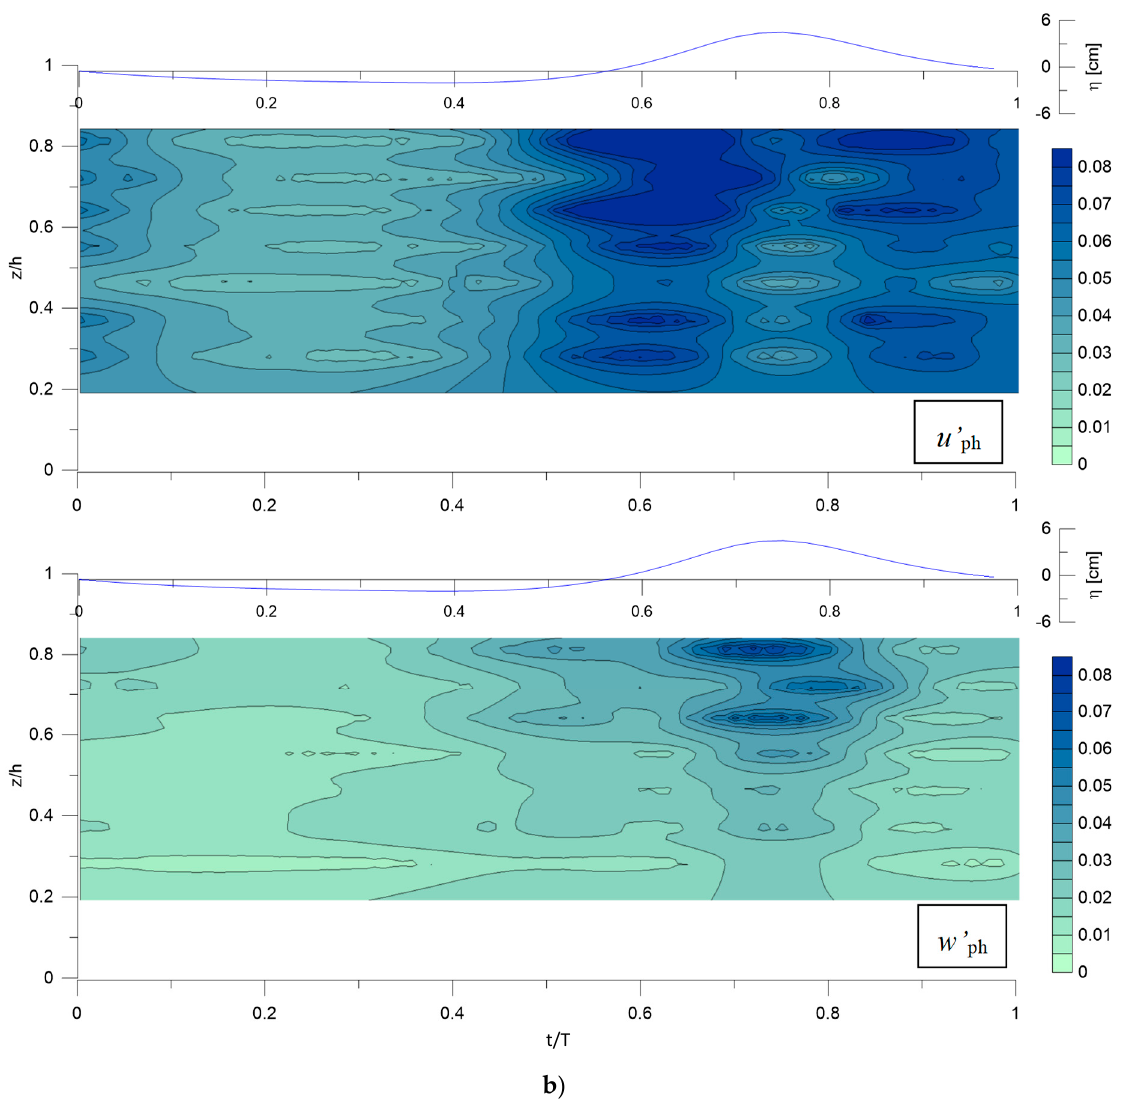
Figure 3. Section 47: phase-averaged turbulent intensities in the wave cycle at all the investigated depths: ( a ) u ’ ph and w ’ ph for Test_P; ( b ) u ’ ph and w ’ ph for Test_S. Units are in m/s.